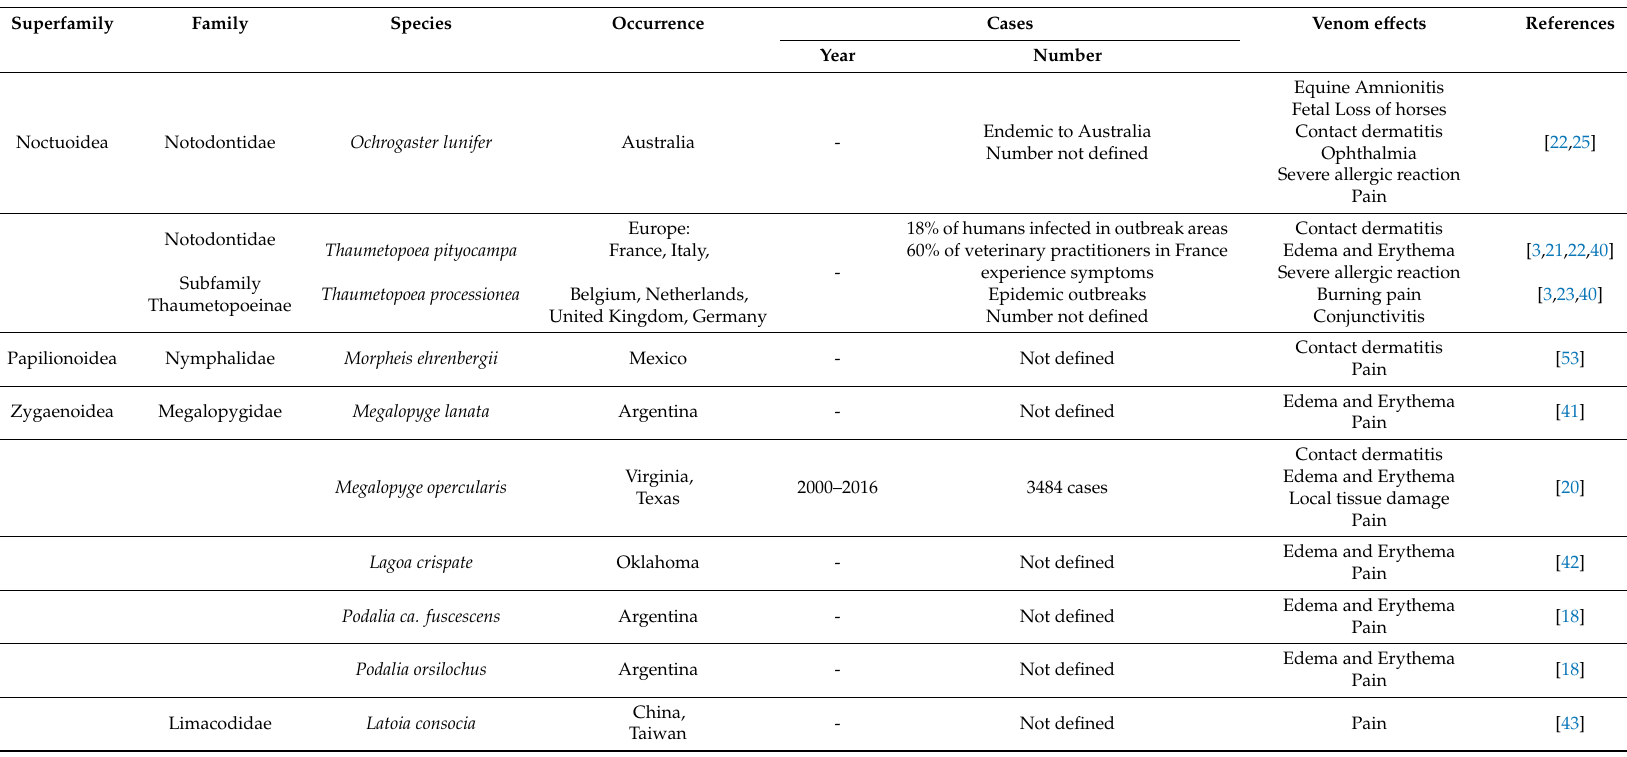
Table 2. Occurrence, cases and venom e ff ects from caterpillars of moths described in this review. The table shows seven of the nine venomous caterpillar families. For the Eucliedae and Nymphalidae family, no reference in the literature was found of envenomation